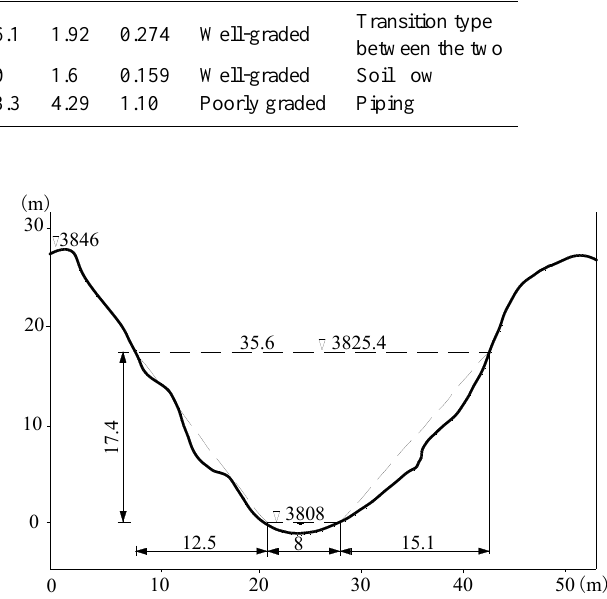
Fig.4. The cross sectional profile of breach in the Guangxieco Lake (The number is in units of 2